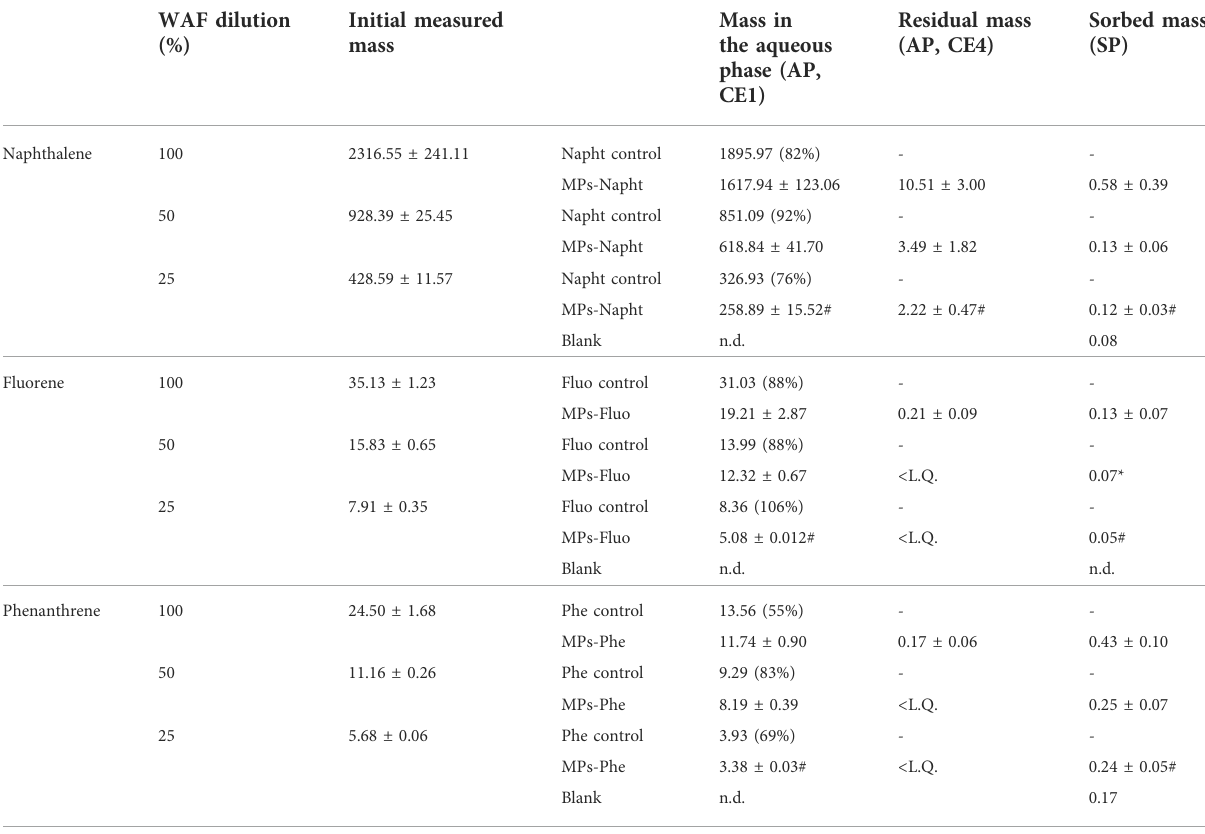
TABLE 3 PAH mass (in ng) for the different fractions